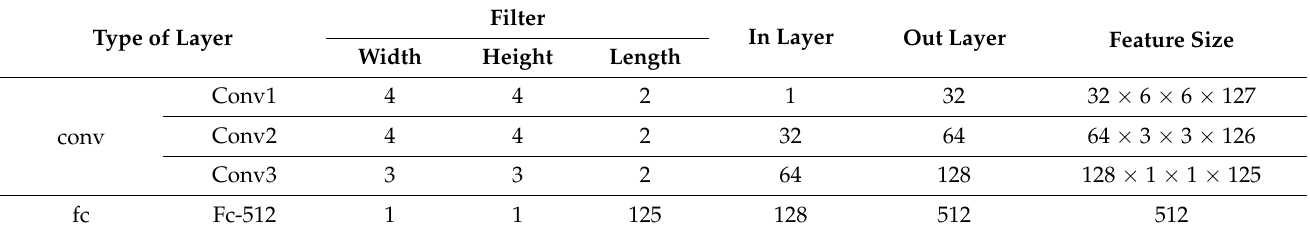
Table 2. The structural parameters of